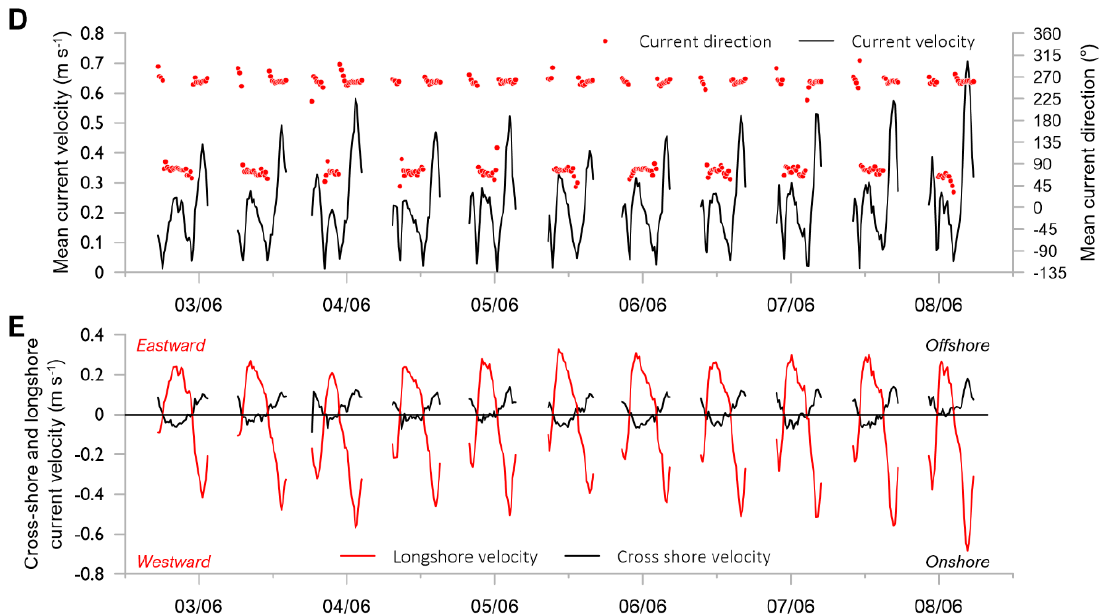
J. Mar. Sci. Eng. 2021 , 9 , 909 9 of 27 Figure 3. Time series of wind data and hydrodynamic parameters recorded from 2 to 8 June 2013 on bar B3 on the lower beach (see Figure 2D for location) and offshore of the studied beach. ( A ) Wind velocity and direction recorded at the Dunkirk weather station; ( B ) water level changes recorded in 5 m water depth (relative to Hydrographic Datum); ( C ) significant wave height ( H s ); ( D ) mean current velocity and ( E ) longshore and cross-shore current velocity recorded on bar B3.